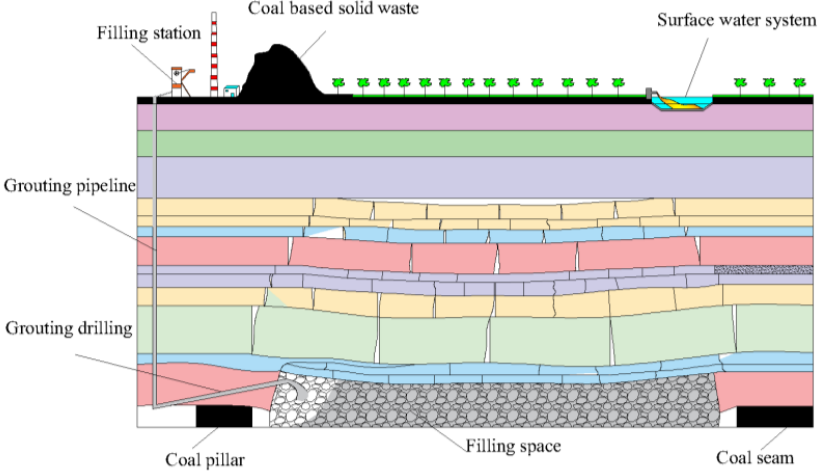
Figure 2. Application of coal-based solid waste in paste filling.